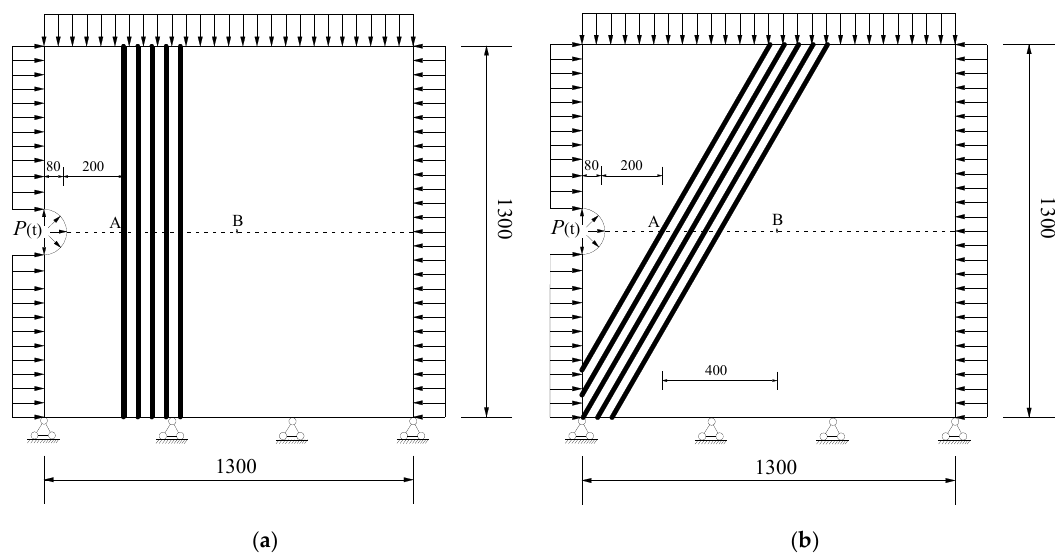
Figure 13. Numerical calculation model of the rock mass containing five joints with different angles (unit: mm): ( a ) joint angle of 90°; ( b ) joint angle of 60°.